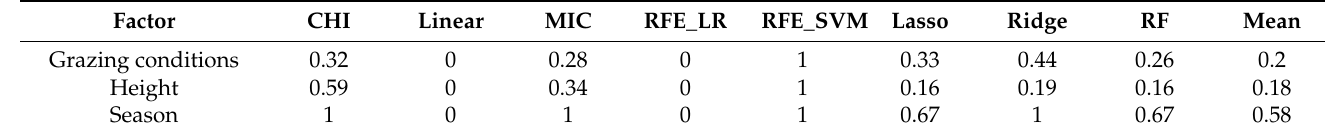
Table 2. Scores of three factors in different feature selection.